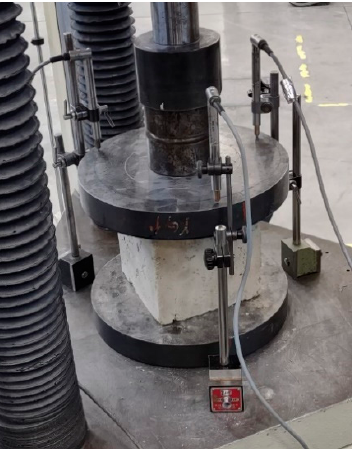
Figure 4. Placement of the three LVDTs on the bottom plate of the testing machine.